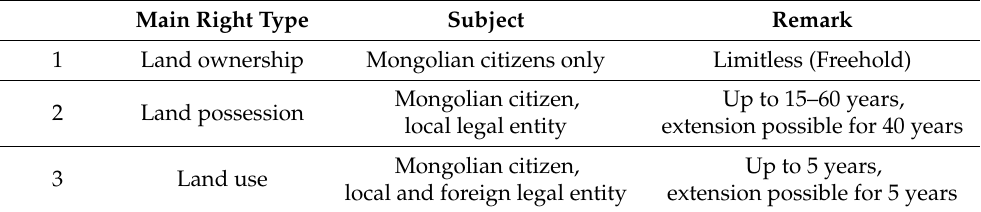
Table 1. Main types of land